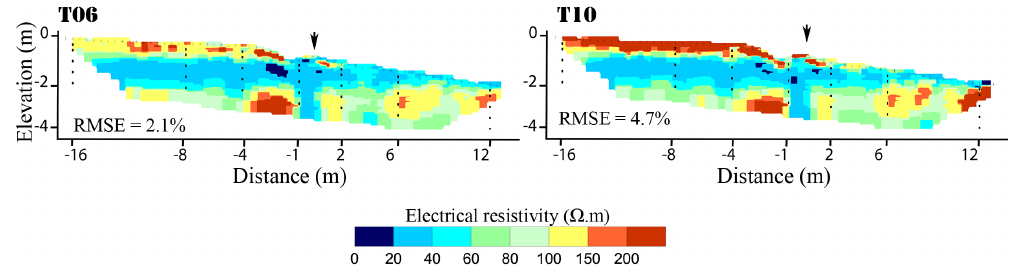
Figure 4. ERT maps for the wettest (T06) and driest (T10) states. The 10 measurement dates (from T01 to T10) are in Fig. S5. Black points indicate tensiometer locations and black arrow the hedgerow location.